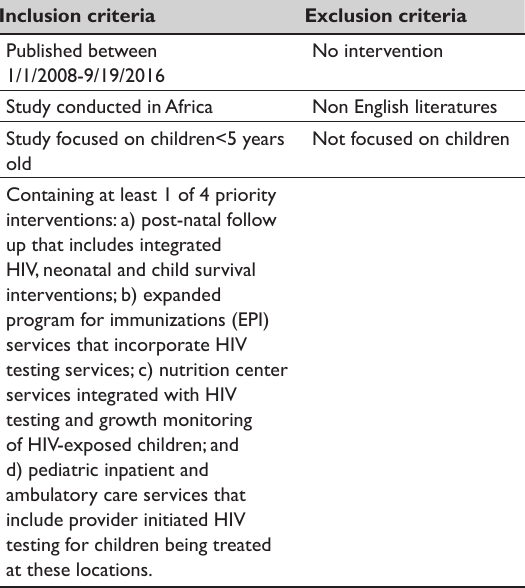
Table 1: Keywords used for systematic search (((((pediatric OR paediatric OR child* OR infant* OR neonat* OR newborn OR under-five OR U-5)) AND (HIV AND (testing OR diagnosis OR treatment OR ART))) AND (postnatal OR PNC OR postpartum OR immuniz* OR immunis* OR EPI OR RED OR nutrition* OR growth monitor* OR supplemental feed* OR malnutrition OR IYCF OR CMAM OR CTC OR developmental assessment OR IMCI OR iCCM OR ((pediatric OR paediatric OR child* OR infant* OR neonat* OR newborn OR under-five OR U-5) AND (community-based OR primary care OR center OR facility OR clinic OR ward OR hospital))))) Table 2: Inclusion and exclusion criteria Inclusion